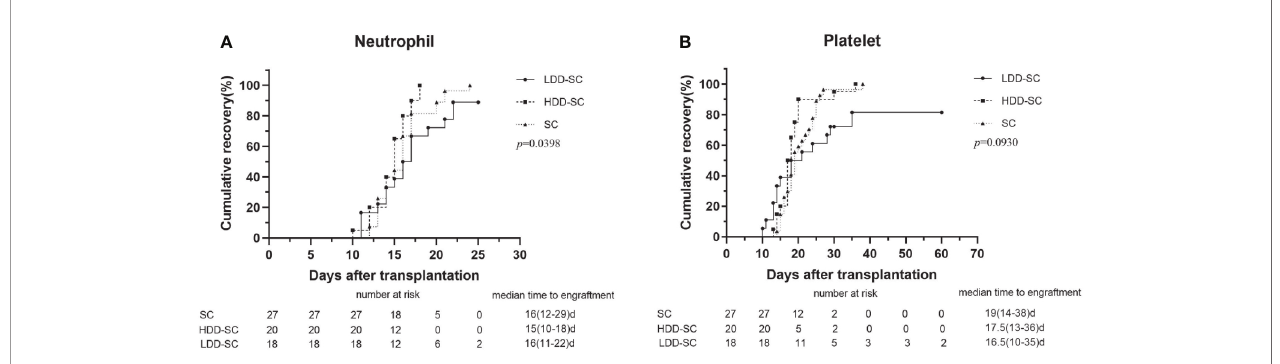
FIGURE 1 | Cumulative incidence of engraftment. (A) Time to neutrophils recovery above 0.5 × 10 9 /L. (B) Time to platelets recovery above 20 × 10 9